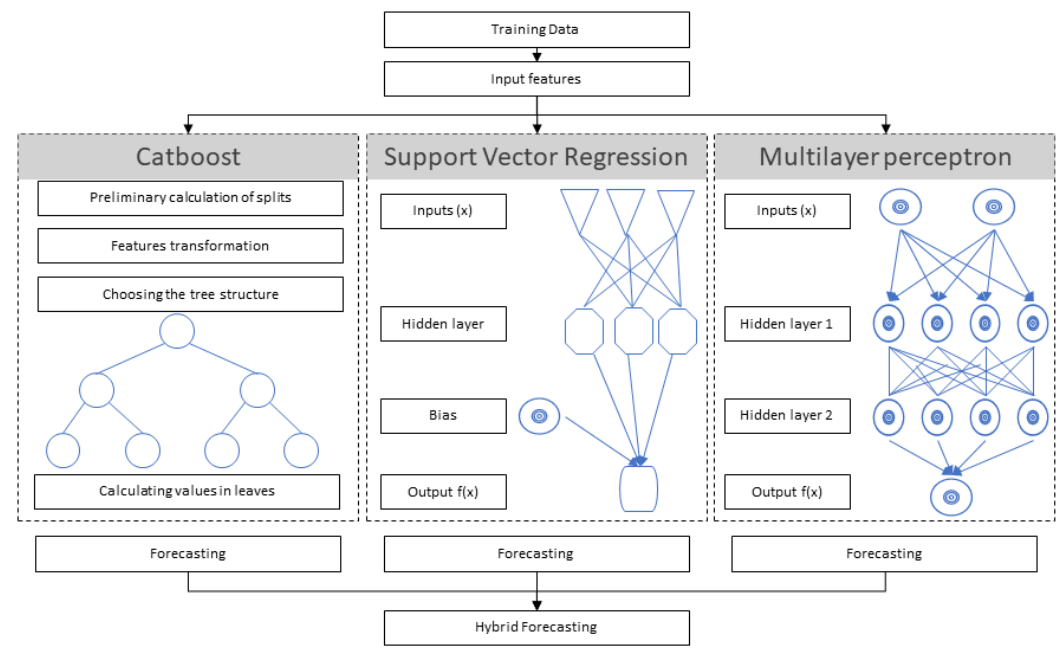
Figure 3. Structure of the proposed hybrid